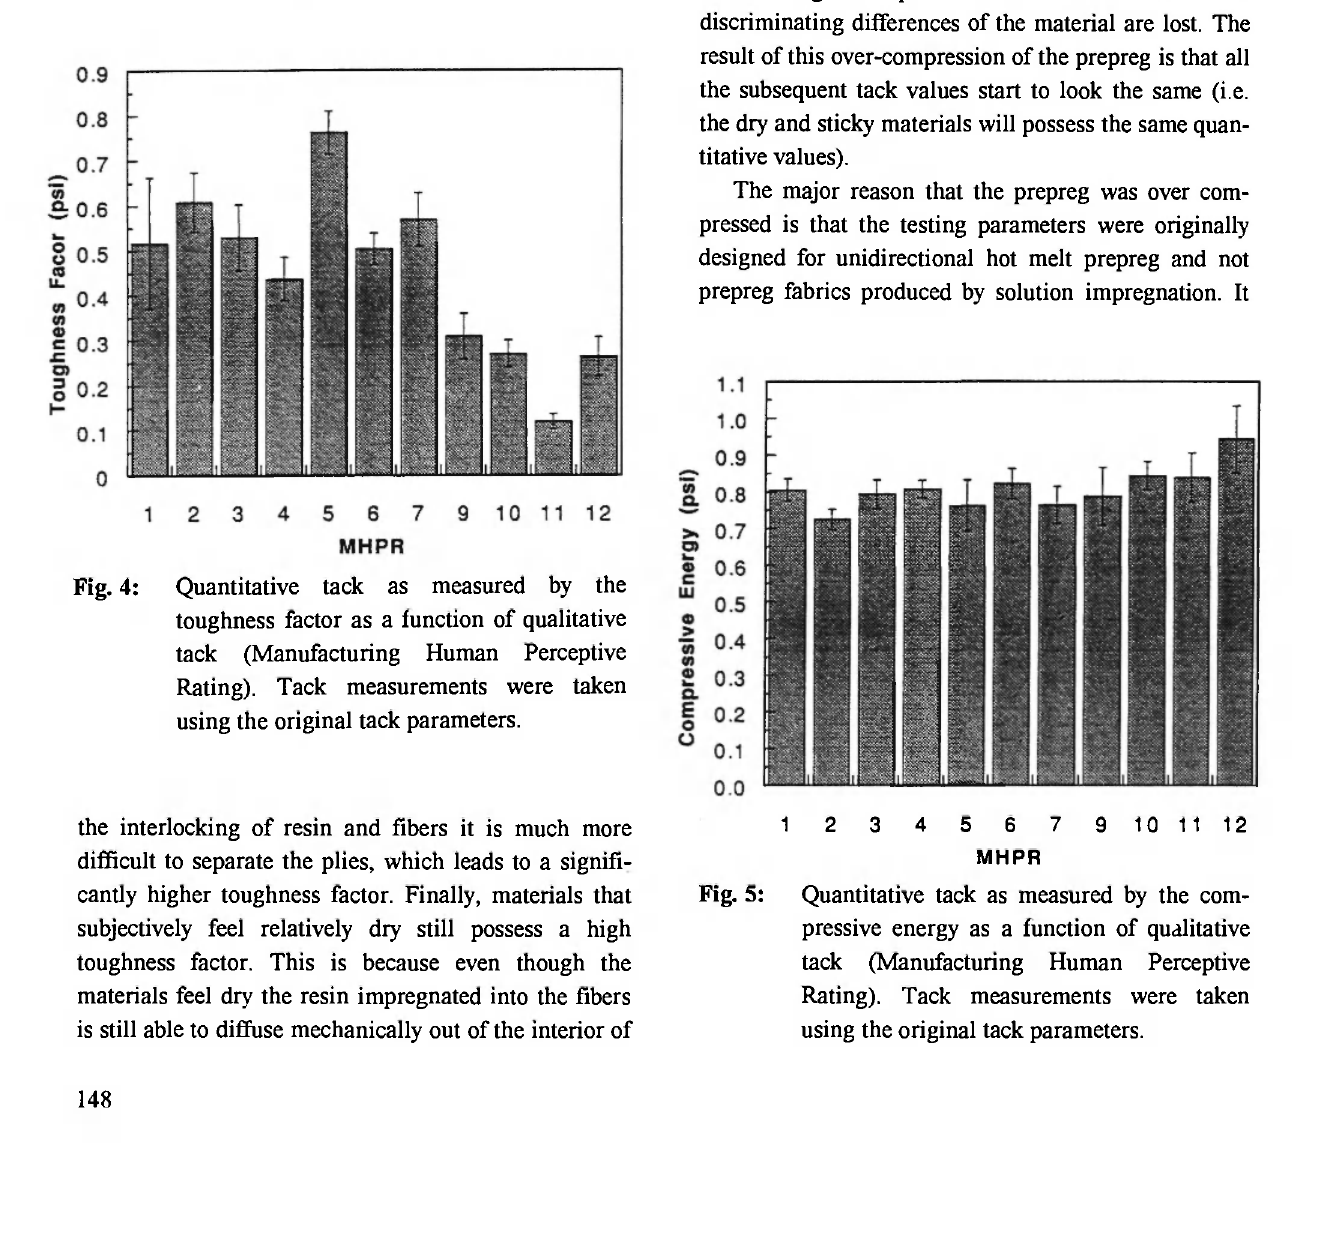
Manufacturing Human Perceptive Rating (MHPR) of qualitative tack from the Boeing manufacturing personnel.